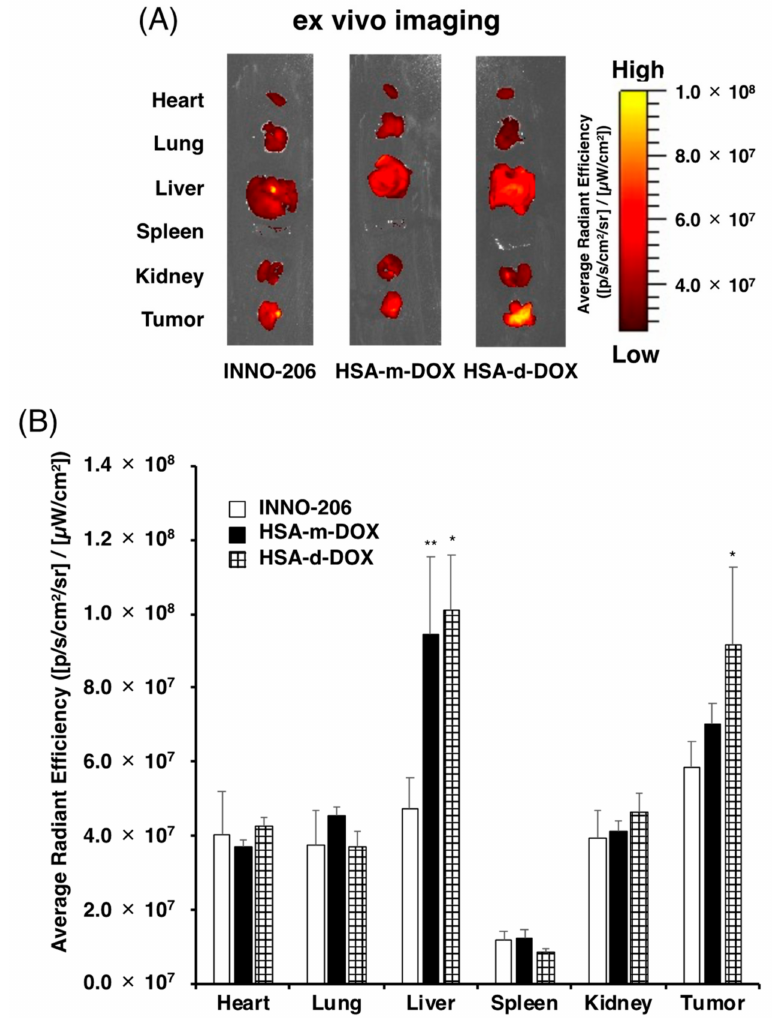
Figure 4. Organ distribution of HSA-DOX. ( A ) ex vivo imaging, ( B ) ex vivo radiant efficiency of the major organs from SUIT2 ectopic tumor bearing mice at 6 h after 8.0 mg (DOX)/kg of INNO-206, HSA-m-DOX and HSA-d-DOX were IV injected. The results obtained for the control group were used to correct for nonspecific background fluorescence. Data are averages ± standard deviation ( n = 3). * p < 0.05, ** p < 0.01 vs.